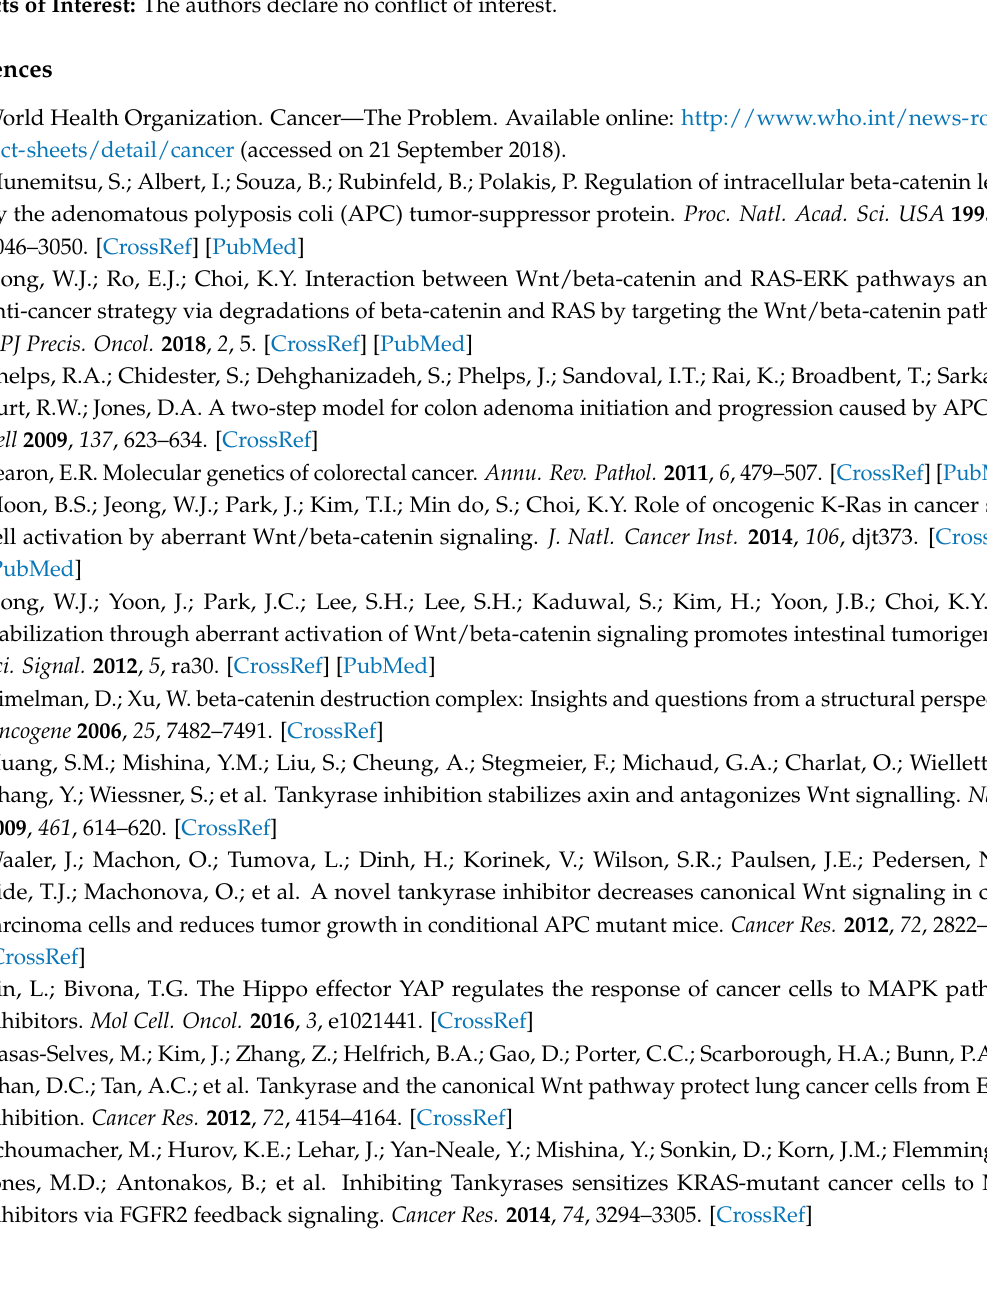
by combined tankyrase and MEK inhibition according to IPA, Table S11: Canonical pathways affected by genes uniquely regulated by combined tankyrase and MEK inhibition according to IPA, Table S12: Upstream regulators affected by genes uniquely regulated by combined tankyrase and MEK inhibition according to IPA, Table S13: DESeq2 analysis showing transcriptional changes induced by tankyrase inhibition compared to DMSO, Table S14: DESeq2 analysis showing transcriptional changes induced by MEK inhibition compared to DMSO, Table S15: DESeq2 analysis showing transcriptional changes induced by combined tankyrase and MEK inhibition compared to DMSO. Supplementary materials and methods